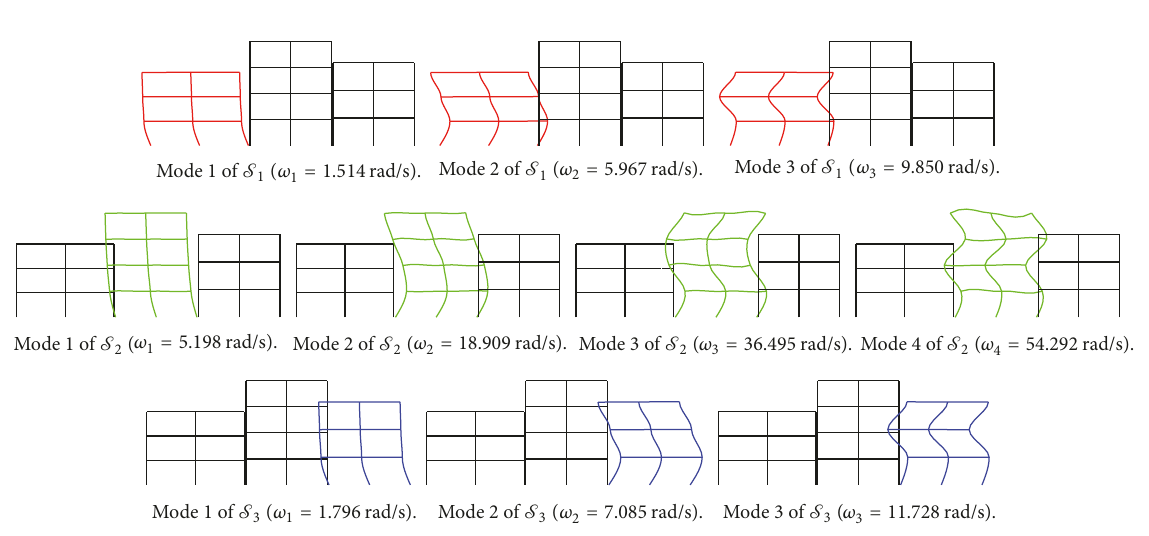
Figure 5: Presentation of the controlled modes.